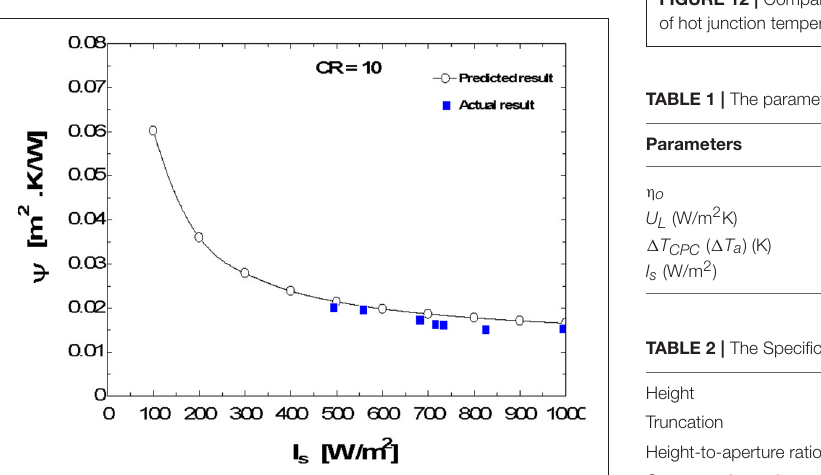
FIGURE 11 | System parameter ψ vs. insolation I s at CR = 10.